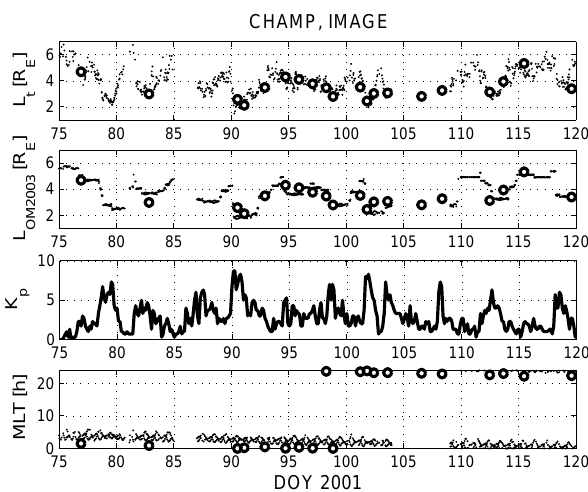
Fig. 4. Variation of plasmapause position. Top panel: The observed L t (for 0 . 5 < a < 10, χ > 90 ◦ ), 2nd panel: the model PP positions, L OM2003 , 3rd panel: K p index, bottom panel: MLT of CHAMP